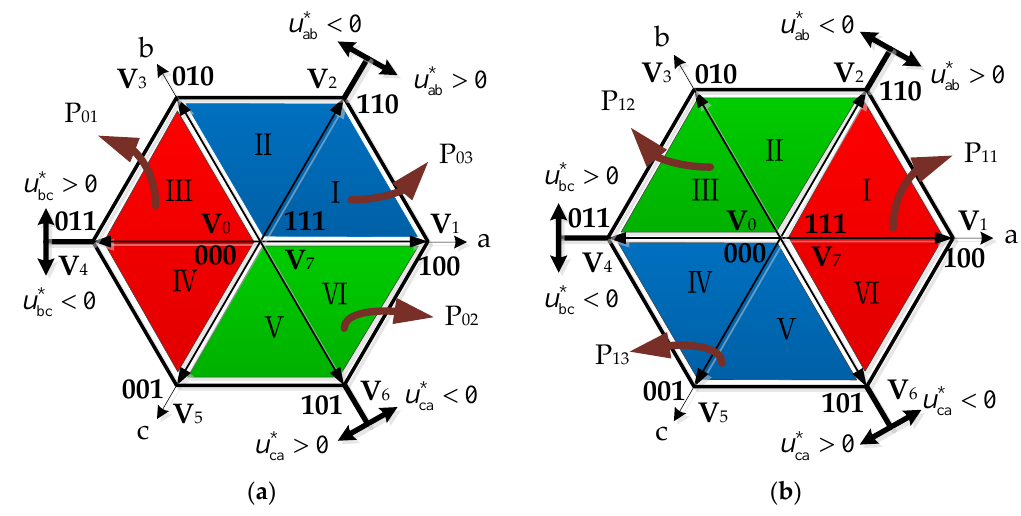
Figure 2. Voltage-space-vectors diagram division obtained under ( a ) mode 0 and ( b ) mode 1.